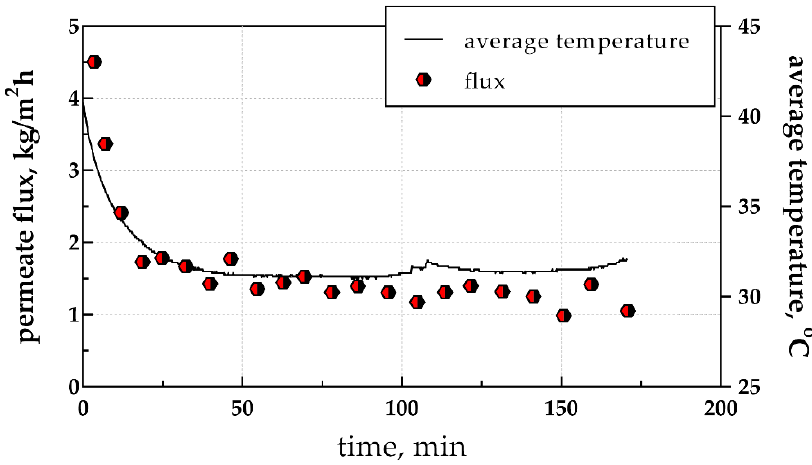
Figure A2. Permeate flux and average feed temperature versus the experiment time. Test with fermented broth; semi-continuous mode.